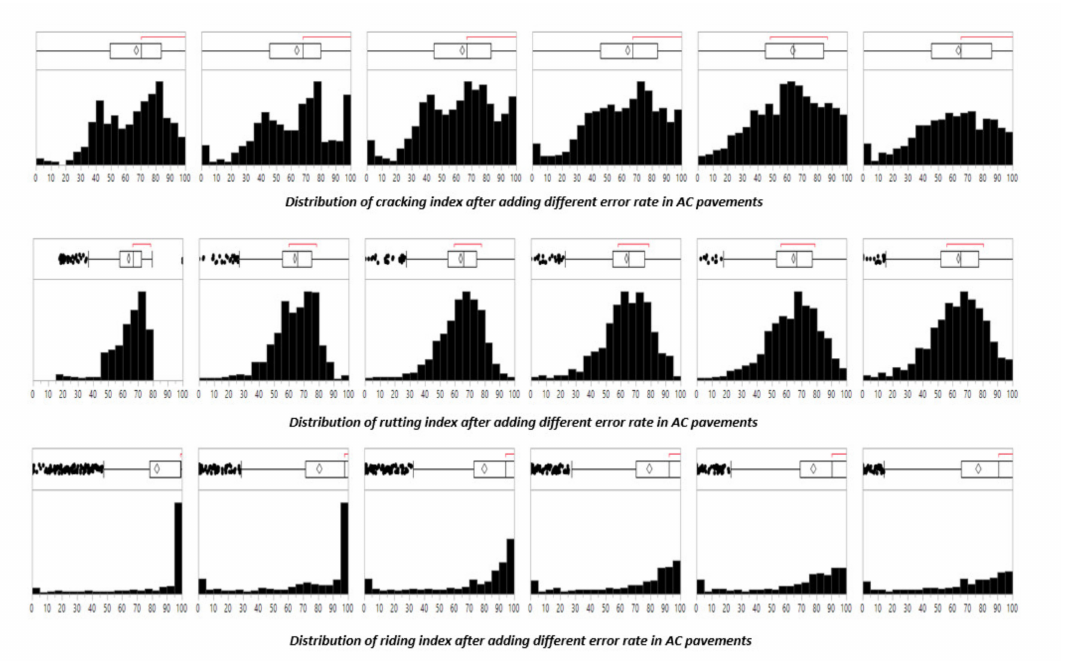
Figure 5. Distribution of individual indexes in AC pavement type after applying the different rate of errors (base scenario, 10%, 30%, 50%, 70%, and 90% rate of error, left to right).